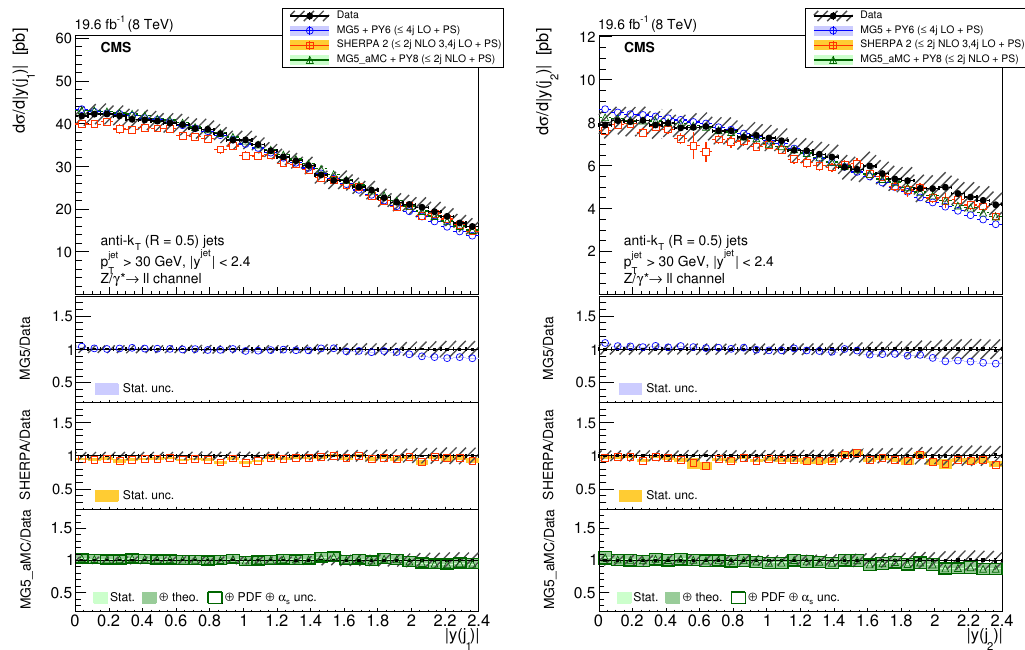
Figure 6 . The di(cid:11)erential cross section for Z ( ! ‘‘ ) + jets production measured as a function of the (left) 1 st and (right) 2 nd jet j y j compared to the predictions calculated with MadGraph 5 + pythia 6, sherpa 2, and mg5 a mc + pythia 8. The lower panels show the ratios of the theoretical predictions to the measurements. Error bars around the experimental points show the statistical uncertainty, while the cross-hatched bands indicate the statistical and systematic uncertainties added in quadrature. The boxes around the mg5 a mc + pythia 8 to measurement ratio represent the uncertainty on the prediction, including statistical, theoretical (from scale variations), and PDF uncertainties. The dark green area represents the statistical and theoretical uncertainties only, while the light green area represents the statistical uncertainty